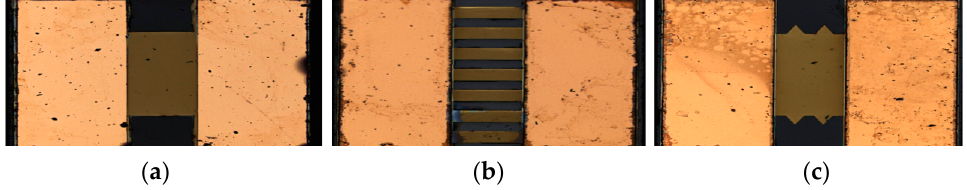
Figure 2. Fabricated Samples of MEMS EC elements. ( a ) Rectangular shape; ( b ) Strip shape; ( c ) An- gular shape.